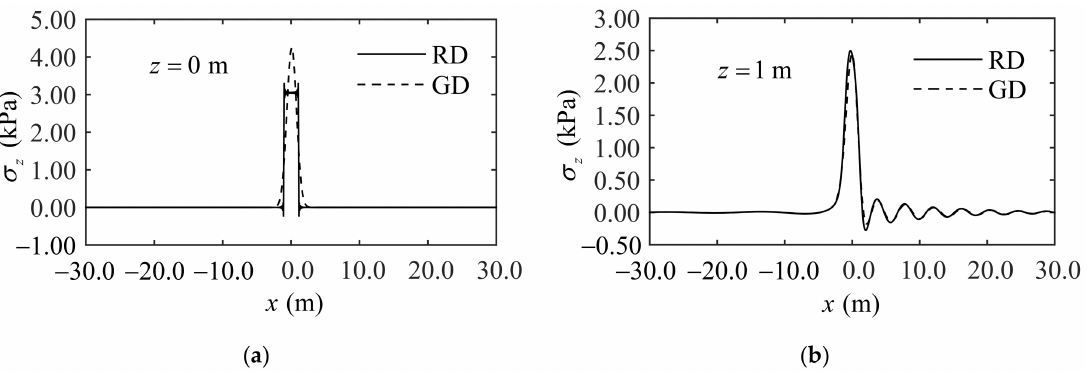
Figure 8. Comparison of stress for the RD and GD at ( a ) interface z = 0 m and ( b ) interface z = 1